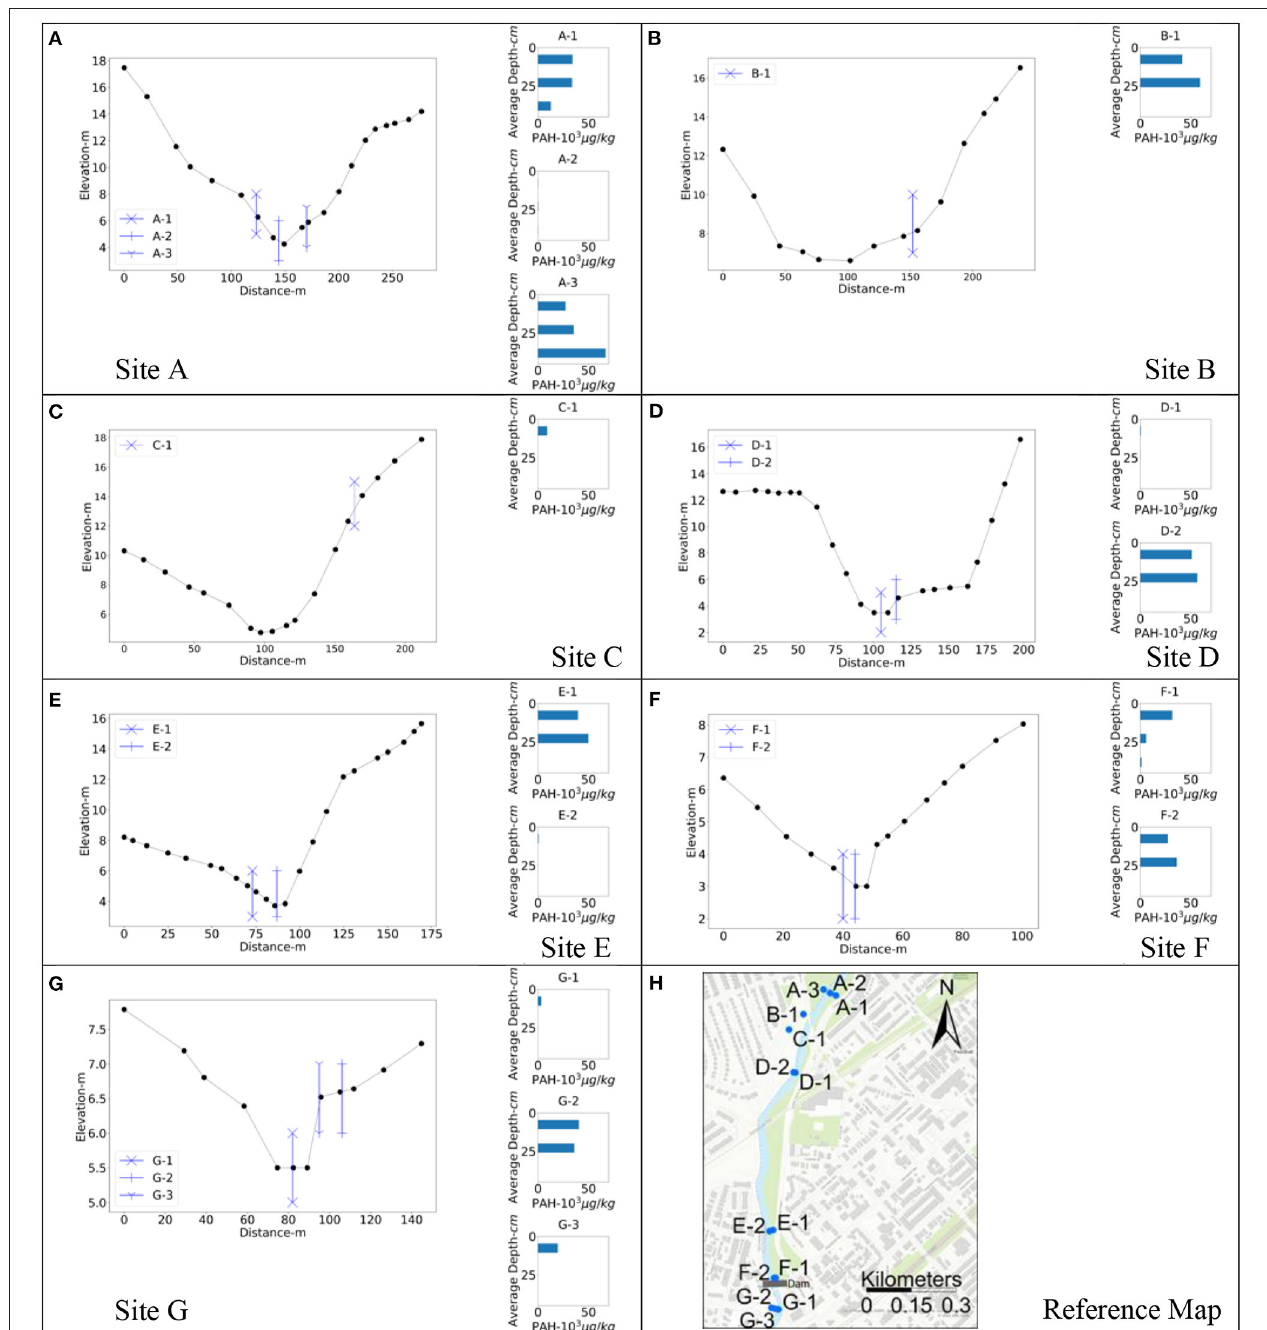
FIGURE 6 | Cross sections of the sampling locations along with measured PAH concentrations at each of the sampling locations (A–G) , aligning with the sites shown in (H) .